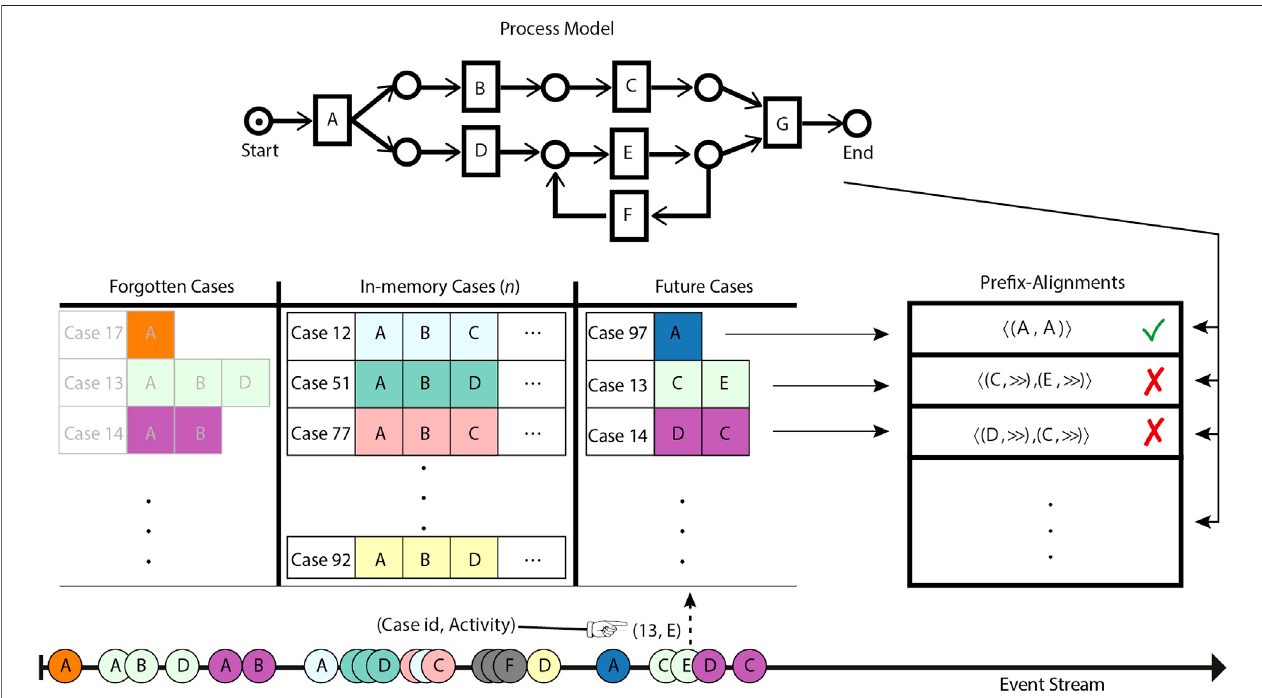
FIGURE 1 | Schematic overview of the bounded-memory online conformance checking.